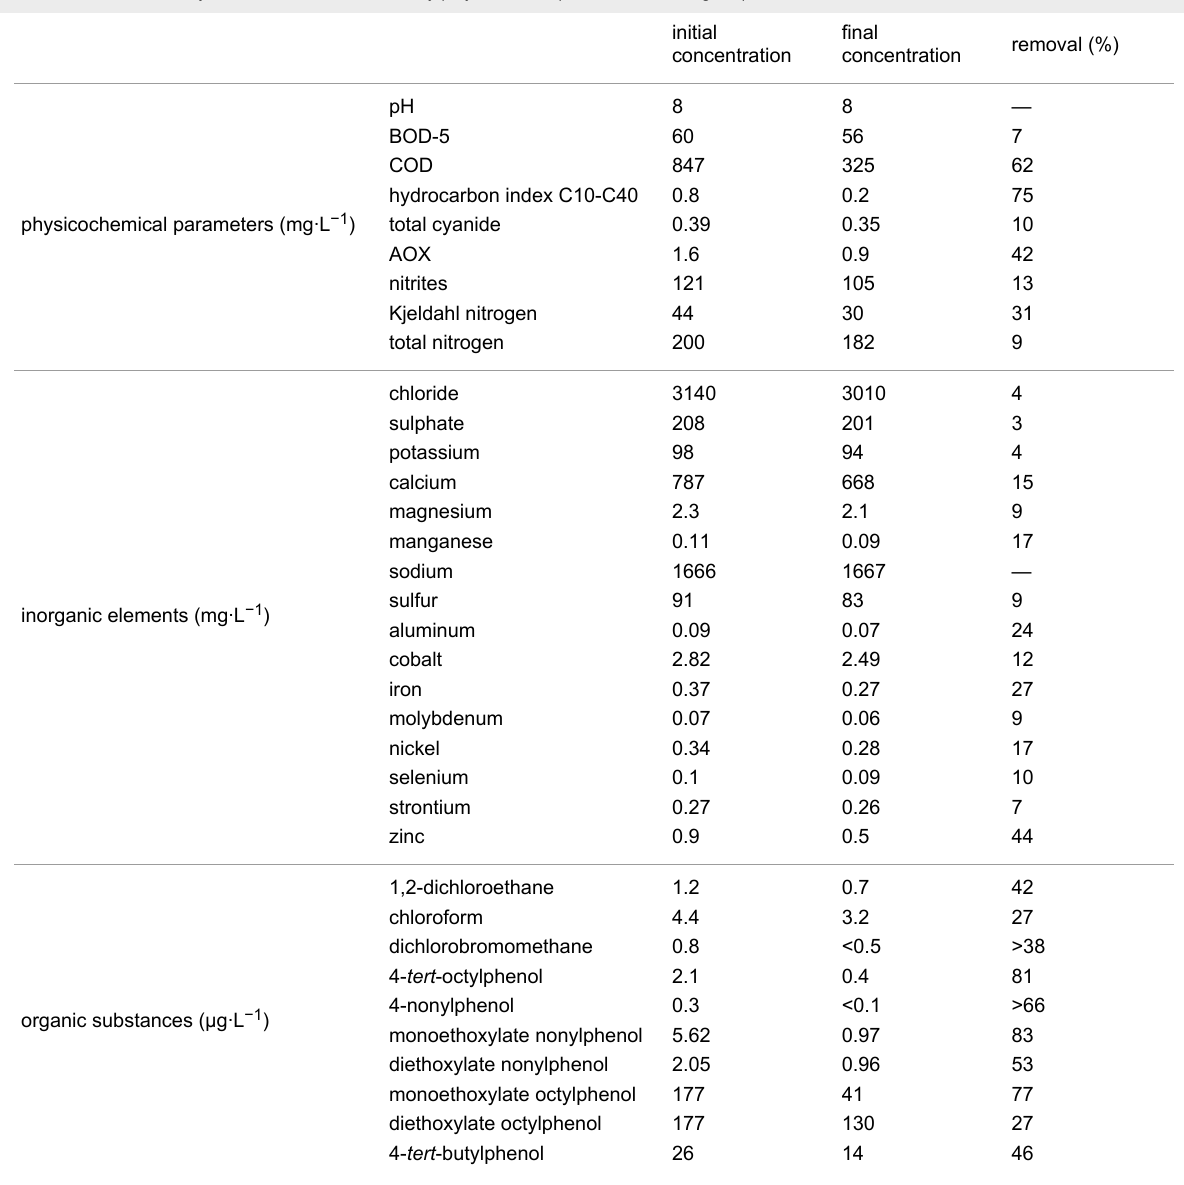
Table 5: Extensive analysis on raw and treated DW by polyBTCA-CD (concentration = 2 g·L − 1 ).